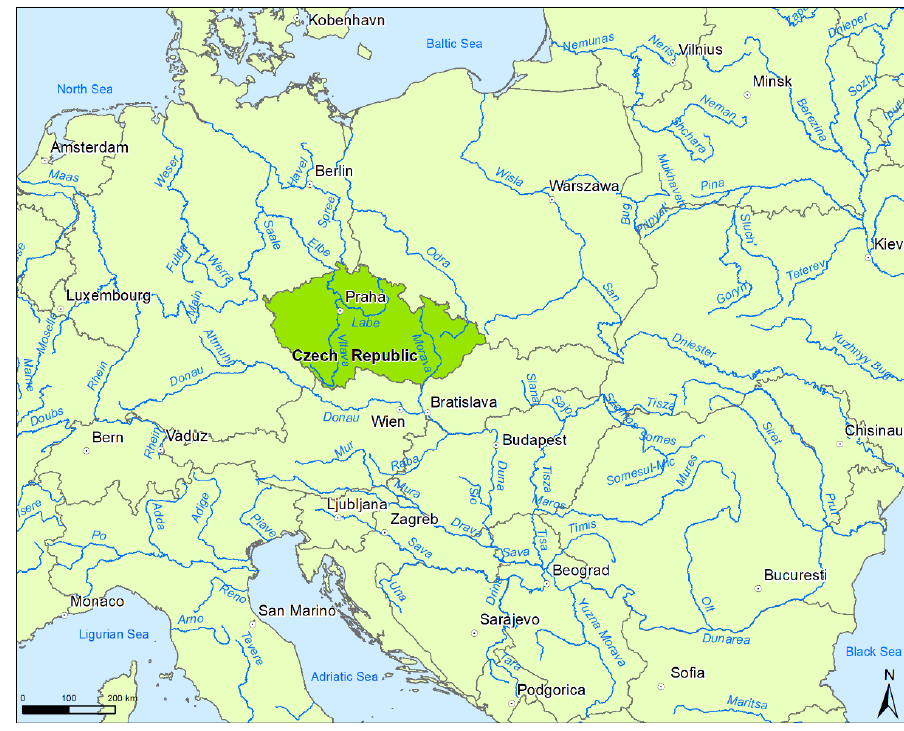
Figure 1. The study area within Europe (The Czech Republic). Table 1. Dams by periods of